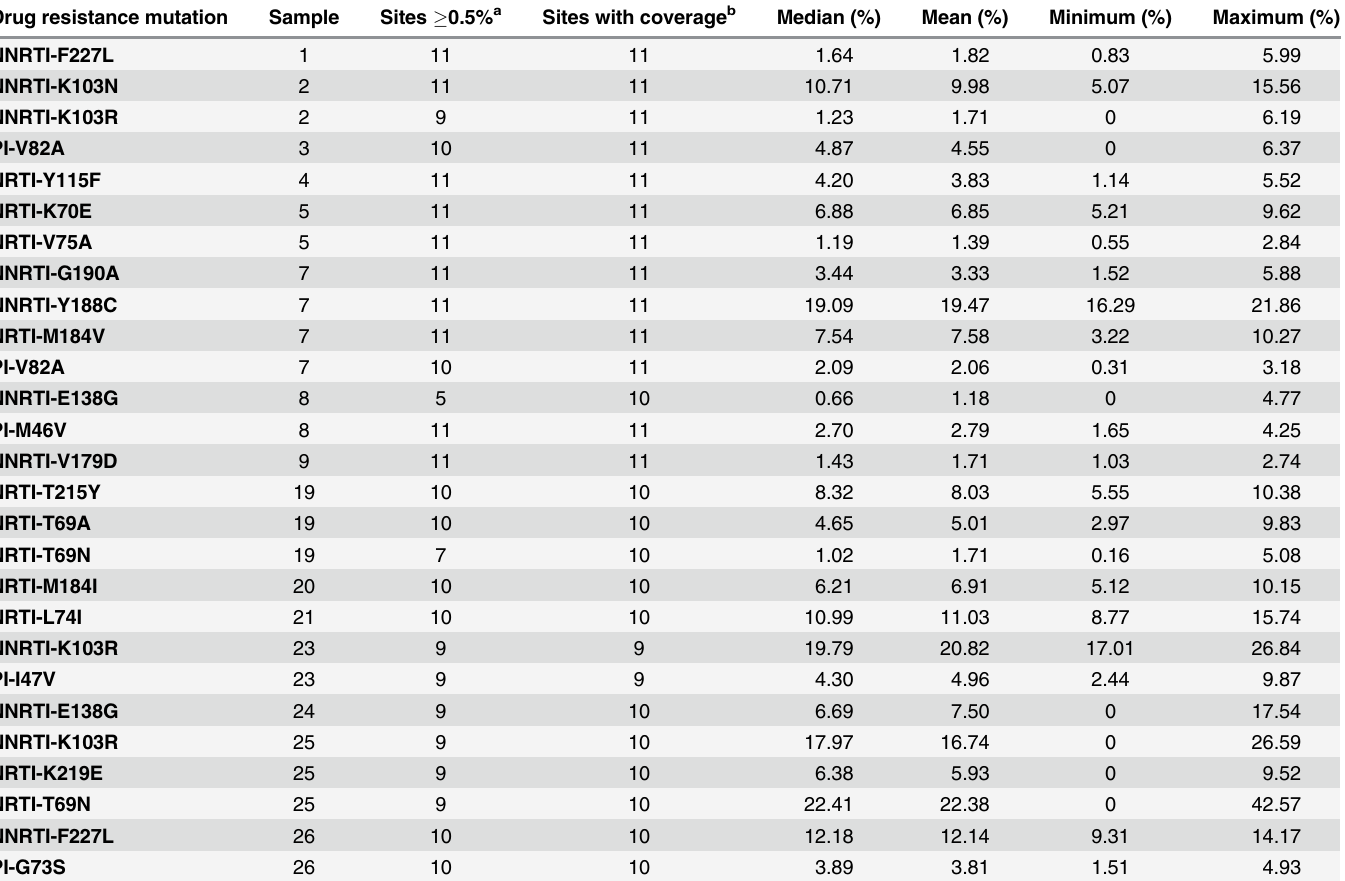
Table 4. Drug resistance mutations found only by UDS. For each detected drug resistance mutation, the table indicates the sample, the number of sites detecting the mutation at a frequency above 0.5%, the number of sites with coverage of at least 15 reads and the median, mean, minimum and maximum vari- ant frequencies. Details on reports of each site are given in Table D in S1